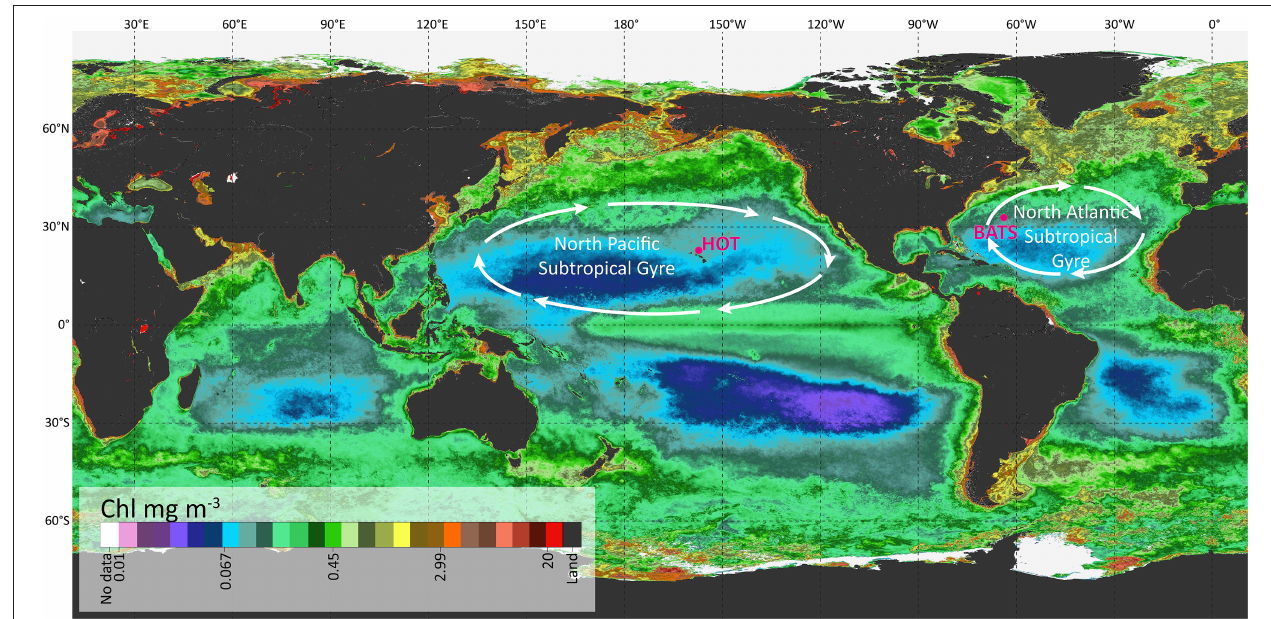
FIGURE 1 | Location of the two stations used in this work: HOT and BATS over a global map representing the annual average of Chl in a color